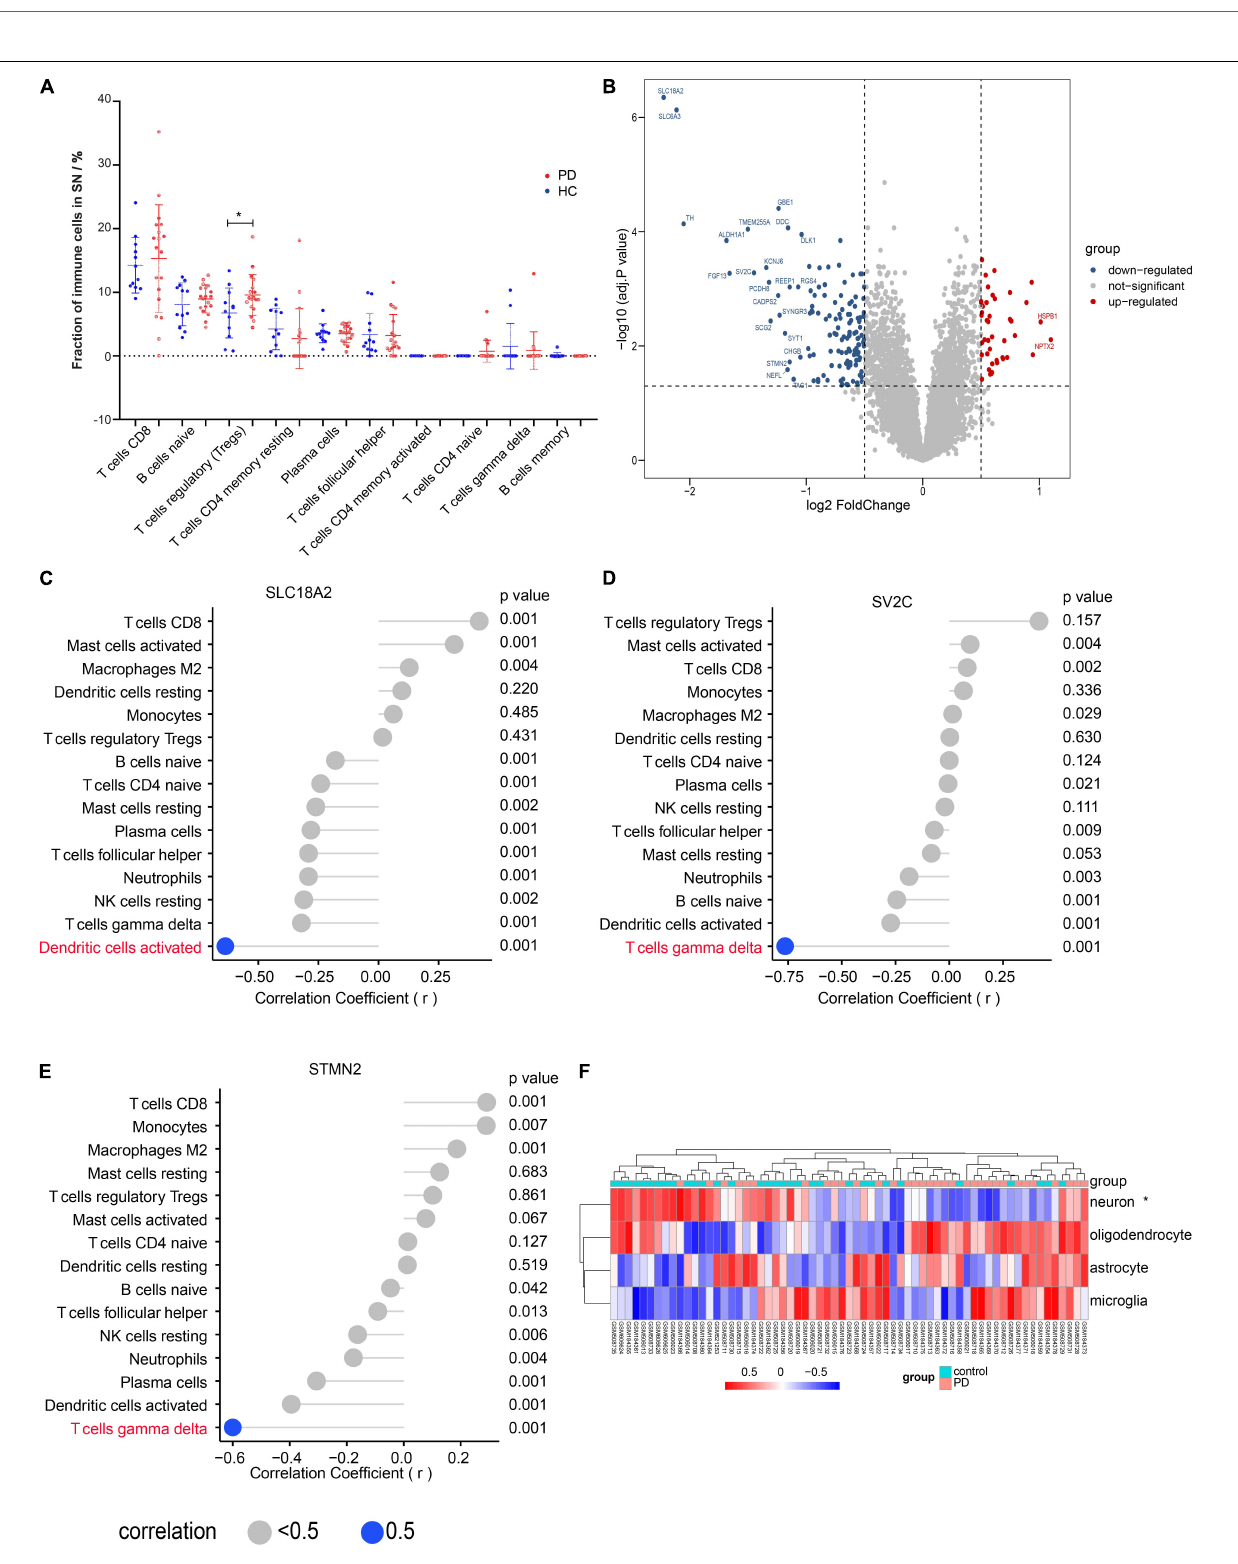
Frontiers in Aging Neuroscience |